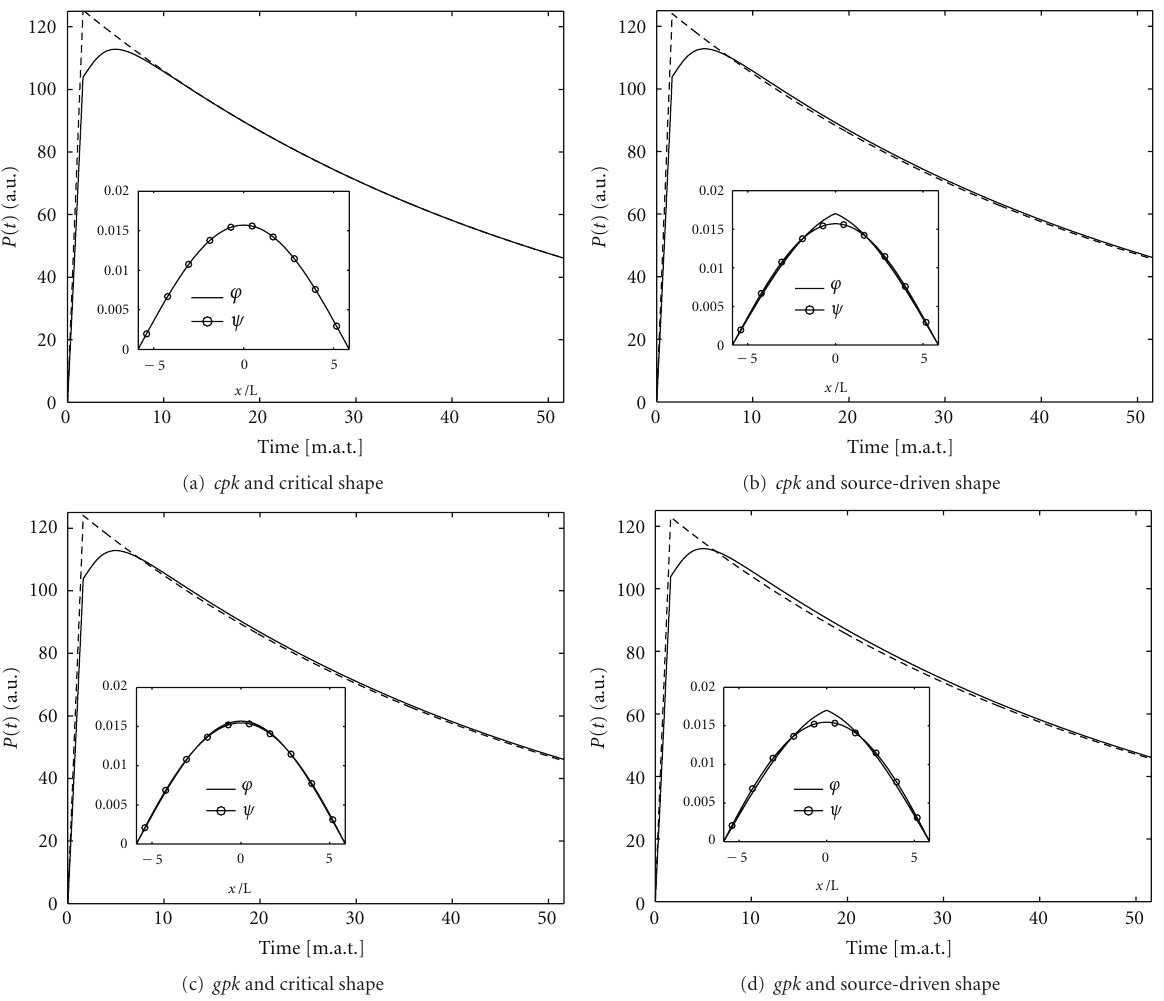
Figure 3: Power evolution following a source pulse in a subcritical system ( k e ff = 0 . 98), simulated with di ff erent approaches to point kinetics: cpk and gpk . Solid line: reference; dashed line: point kinetics. The inset graphs represent the shape ϕ and the weight ψ adopted.